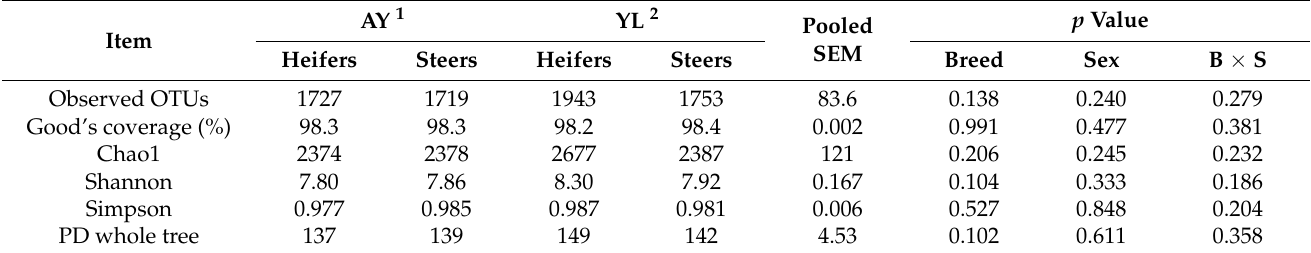
Table 4. Alpha diversity index values of ruminal bacteria in different